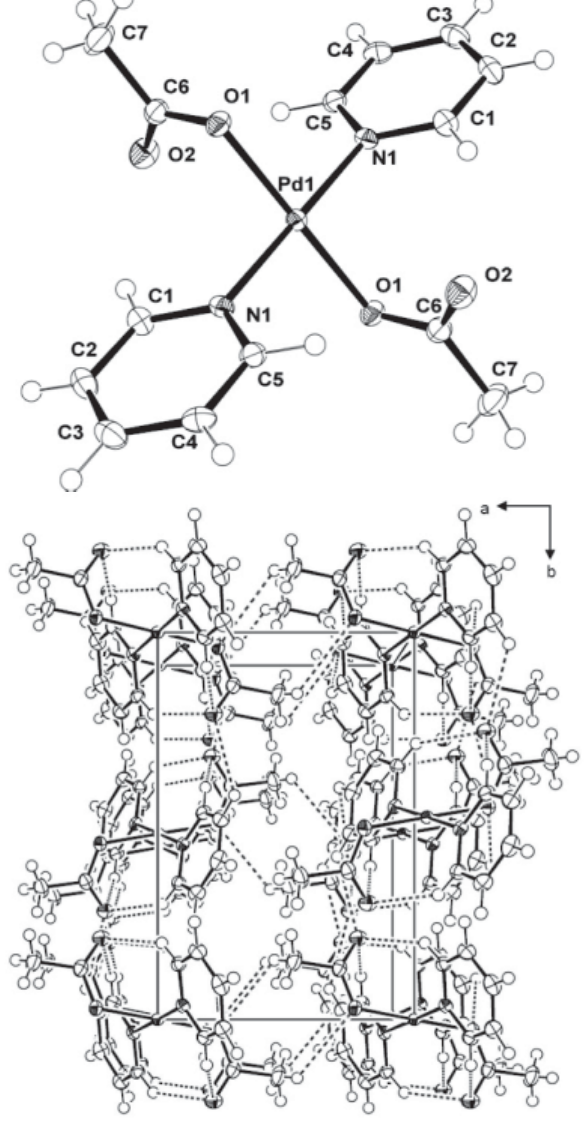
Table 1. Data collection and